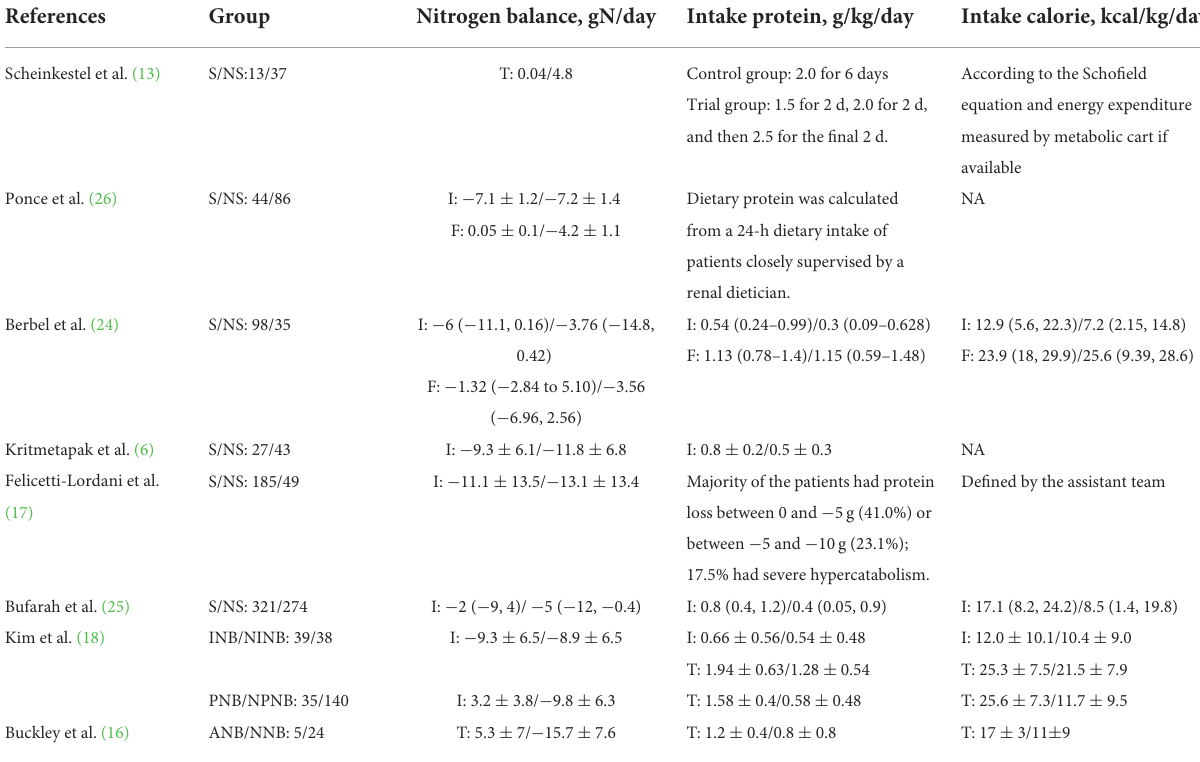
TABLE 2 Summary of the nitrogen balance and Nutrition data in the included studies.